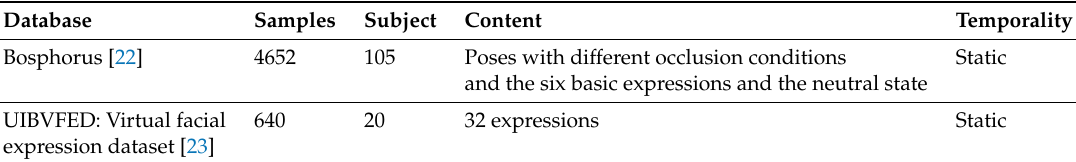
Table 1. 3D facial expressions datasets.